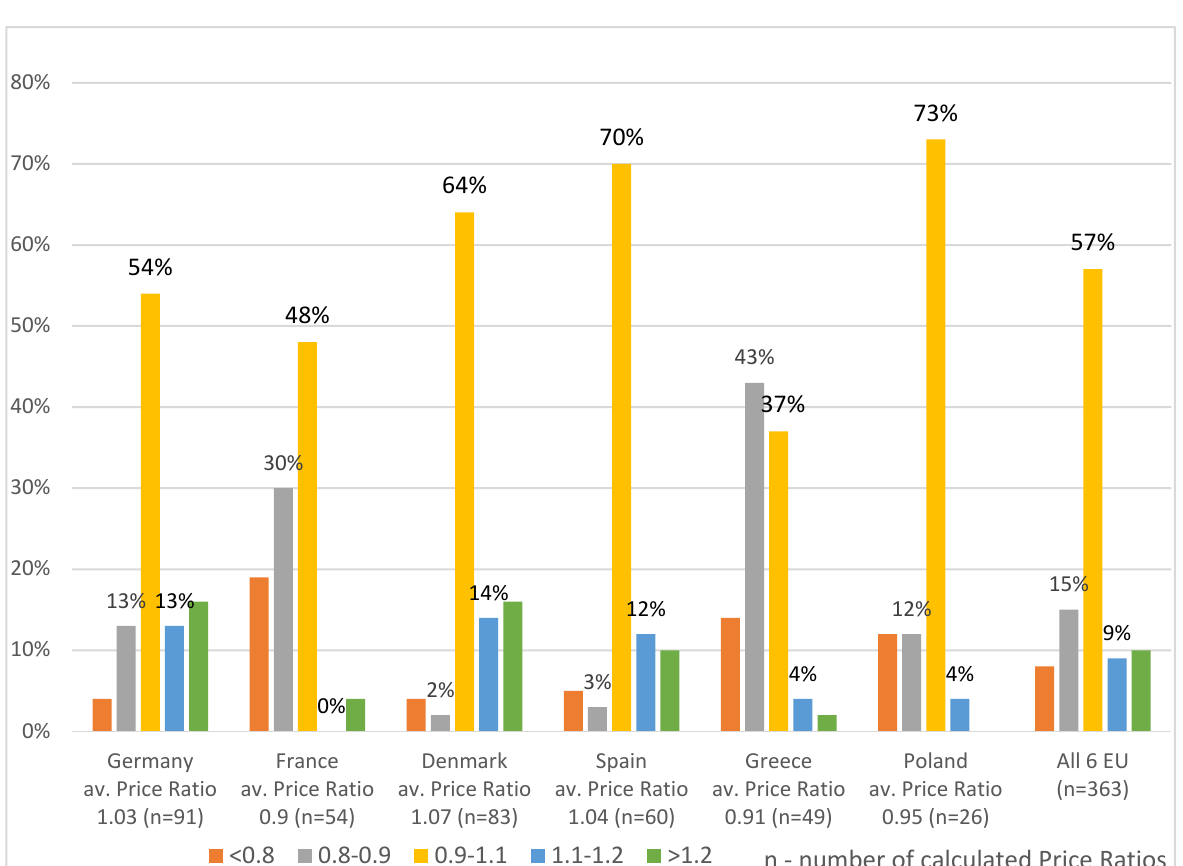
Figure 2. Orphan Drugs Average Price Ratios—segmented by the date of the first FDA approval. Comparison of US vs. six EU Countries (Denmark, France, Germany, Greece, Spain, Poland).